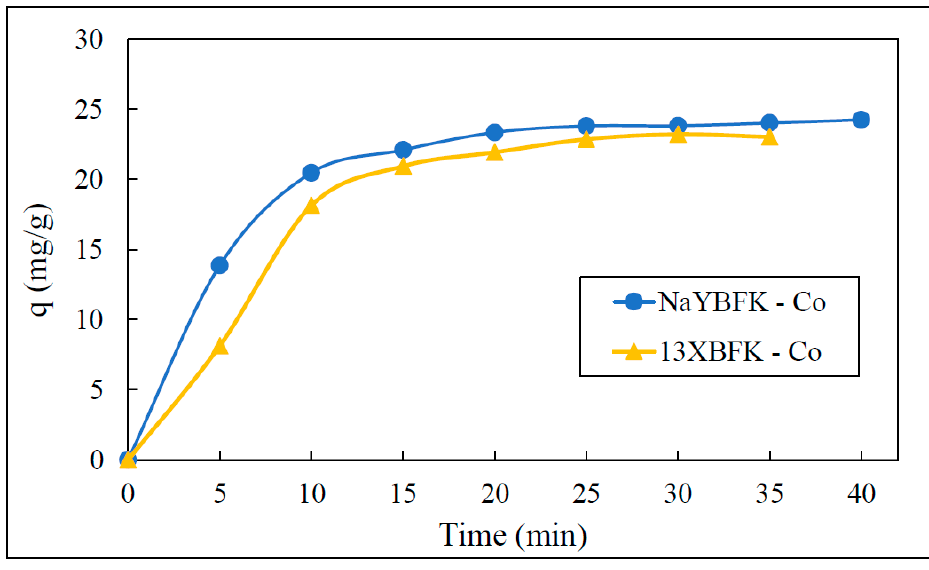
Figure 4. Co 2+ adsorption at 298 K. Conditions: 5 g/L of adsorbent dosage, 1100 rpm, and 40 mg/L of initial Co 2+ concentration.